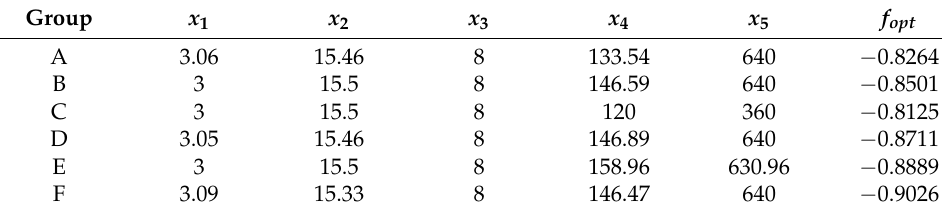
Table 5. The structural parameter optimization results under different weights. Group